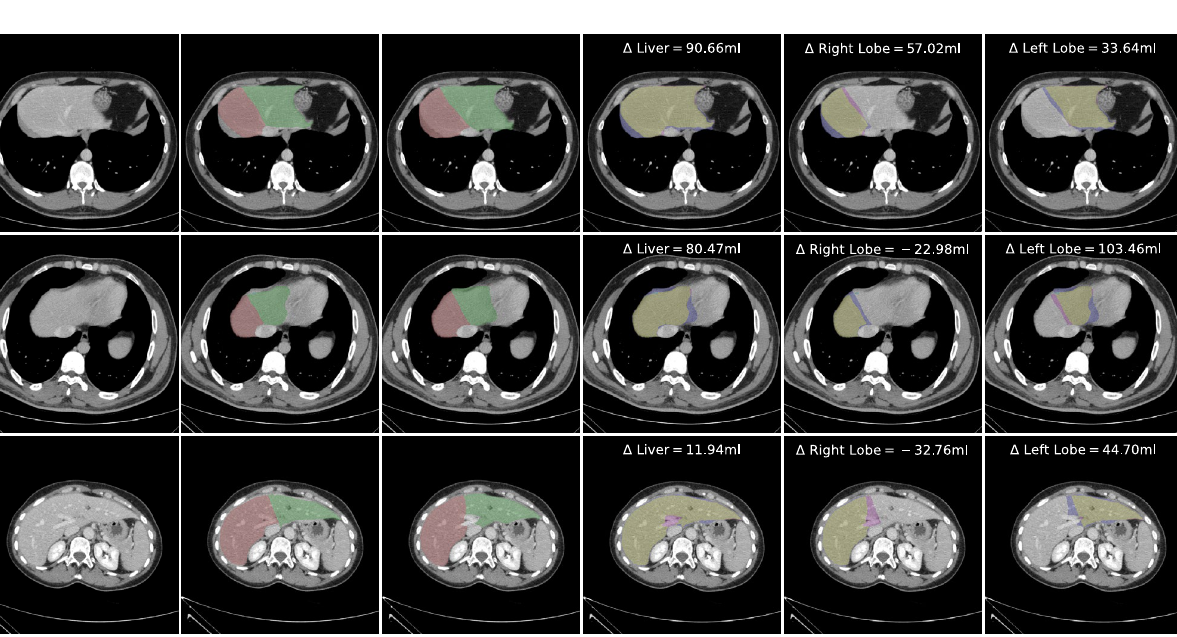
Figure 6. Case studies of three outliers identified by the bland–altman plot. From left to right: original image, SoR annotation, prediction, and error maps for liver, right lobe and left lobe. Error maps show true positives in yellow, false positives in blue, false negatives in pink, and ignored voxels in